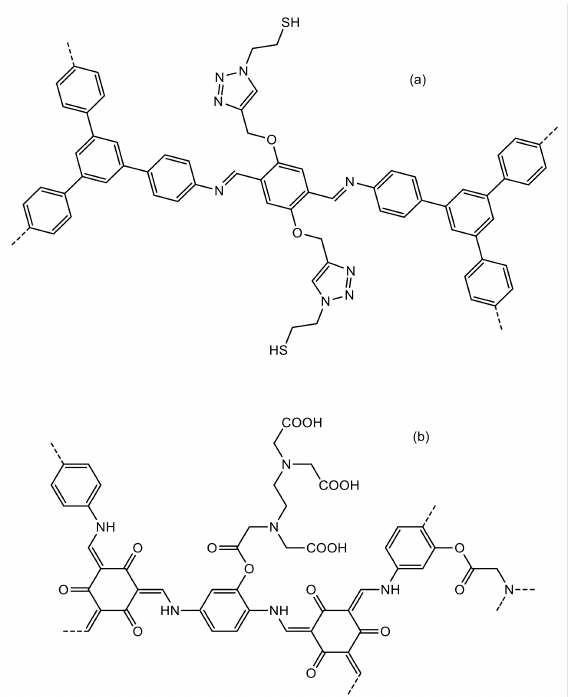
Figure 9. Structures of the functional groups present in ( a ) TPB-DMTP-COF-SH and ( b ) TpPaNH 2 @EDTA